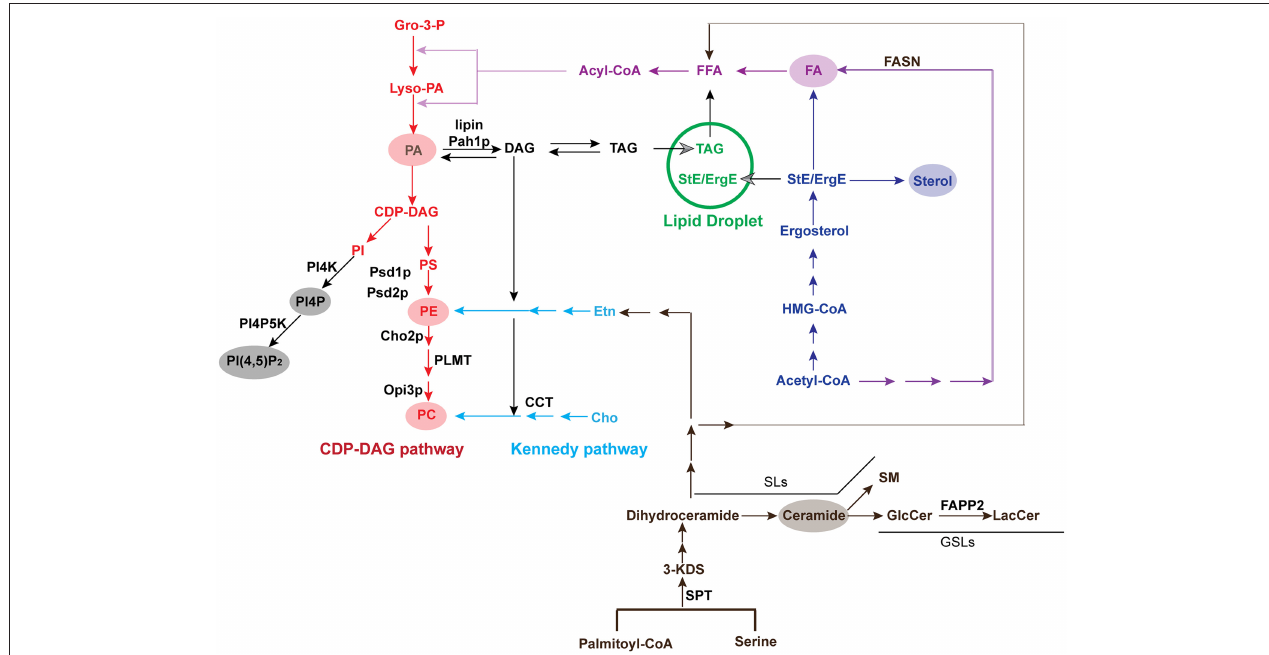
FIGURE 5 | Pathways for the biosynthesis of major lipids. Key enzymes in pathways or those that are recruited by viruses are listed. The conversion from PE to PC is catalyzed by Cho2p and Opi3p in yeast but PLMT in mammals. Yeast or plant Pah1p or mammalian lipin converts DAG to PA. Gro-3-P, glycerol-3-phosphate; Lyso-PA, lysophosphatidic acid; PA, phosphatidic acid; CDP-DAG, cytidine diphosphate diacylglycerol; PI, phosphatidylinositol; PI4K, Phosphatidylinositol-4 kinase; PI4P, phosphatidylinositol-4-phosphate; PI4P5K, phosphatidylinositol 4-phosphate 5-kinase; PI(4,5)P 2 , phosphatidylinositol-4,5-bisphosphate; PS, phosphatidylserine; PE, phosphatidylethanolamine; PC, phosphatidylcholine; Etn, ethanolamine; Cho, choline; DAG, diacylglycerol; TAG, triacylglycerol; StE, steryl ester; ErgE, ergosterol ester; Acyl-CoA, acyl-coenzyme A; FFA, free fatty acid; FA, fatty acid; FASN, fatty acid synthase; HMG-CoA, 3-hydroxy-3-methylglutaryl-coenzyme A; SPT, serine palmitoyltransferase; 3-KDS, 3-ketodihydrosphingosine; GlcCer, glucosylceramide; LacCer, lactosylceramide; SM, sphingomyelin; SL, sphingolipid; GSL, glycosphingolipid; FAPP2, four-phosphate adaptor protein